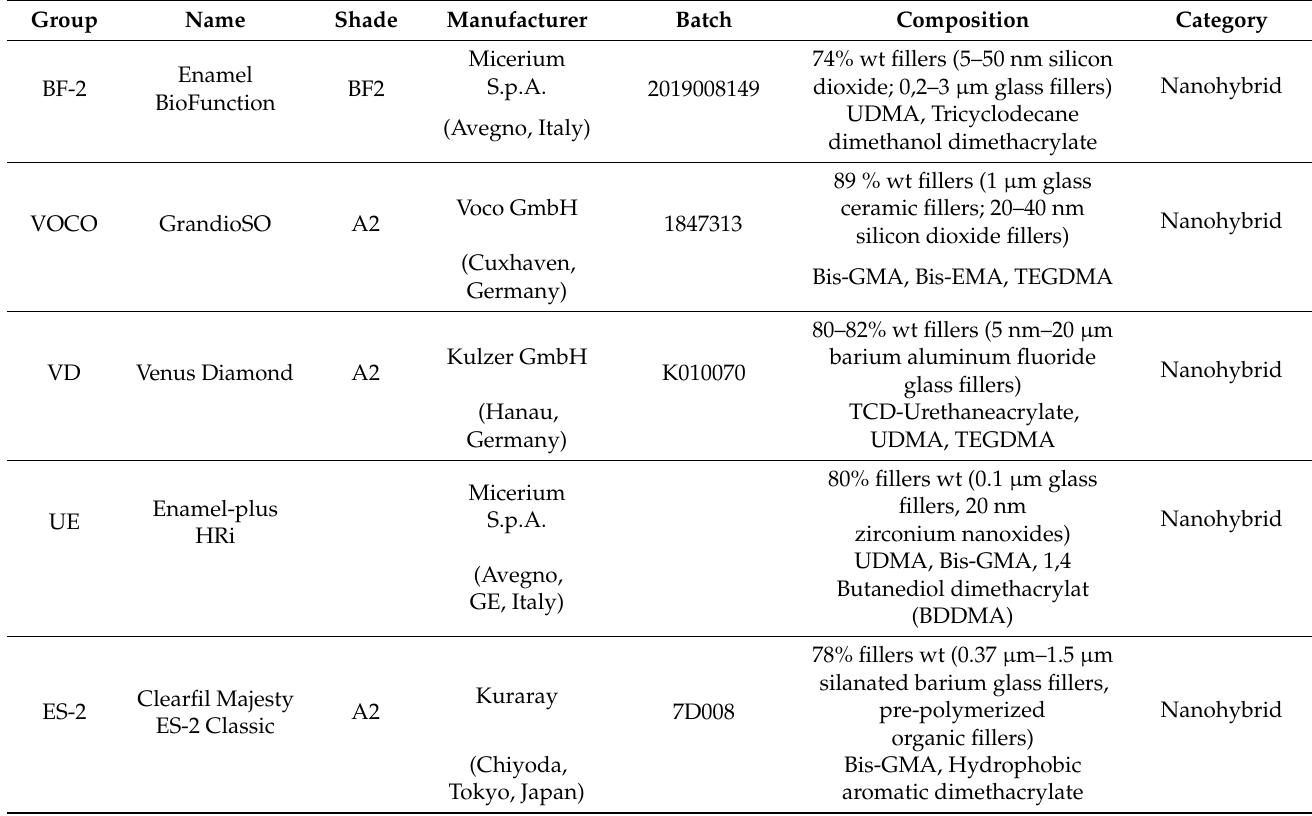
Table 1. List and characteristics of the CRs included in the experimental